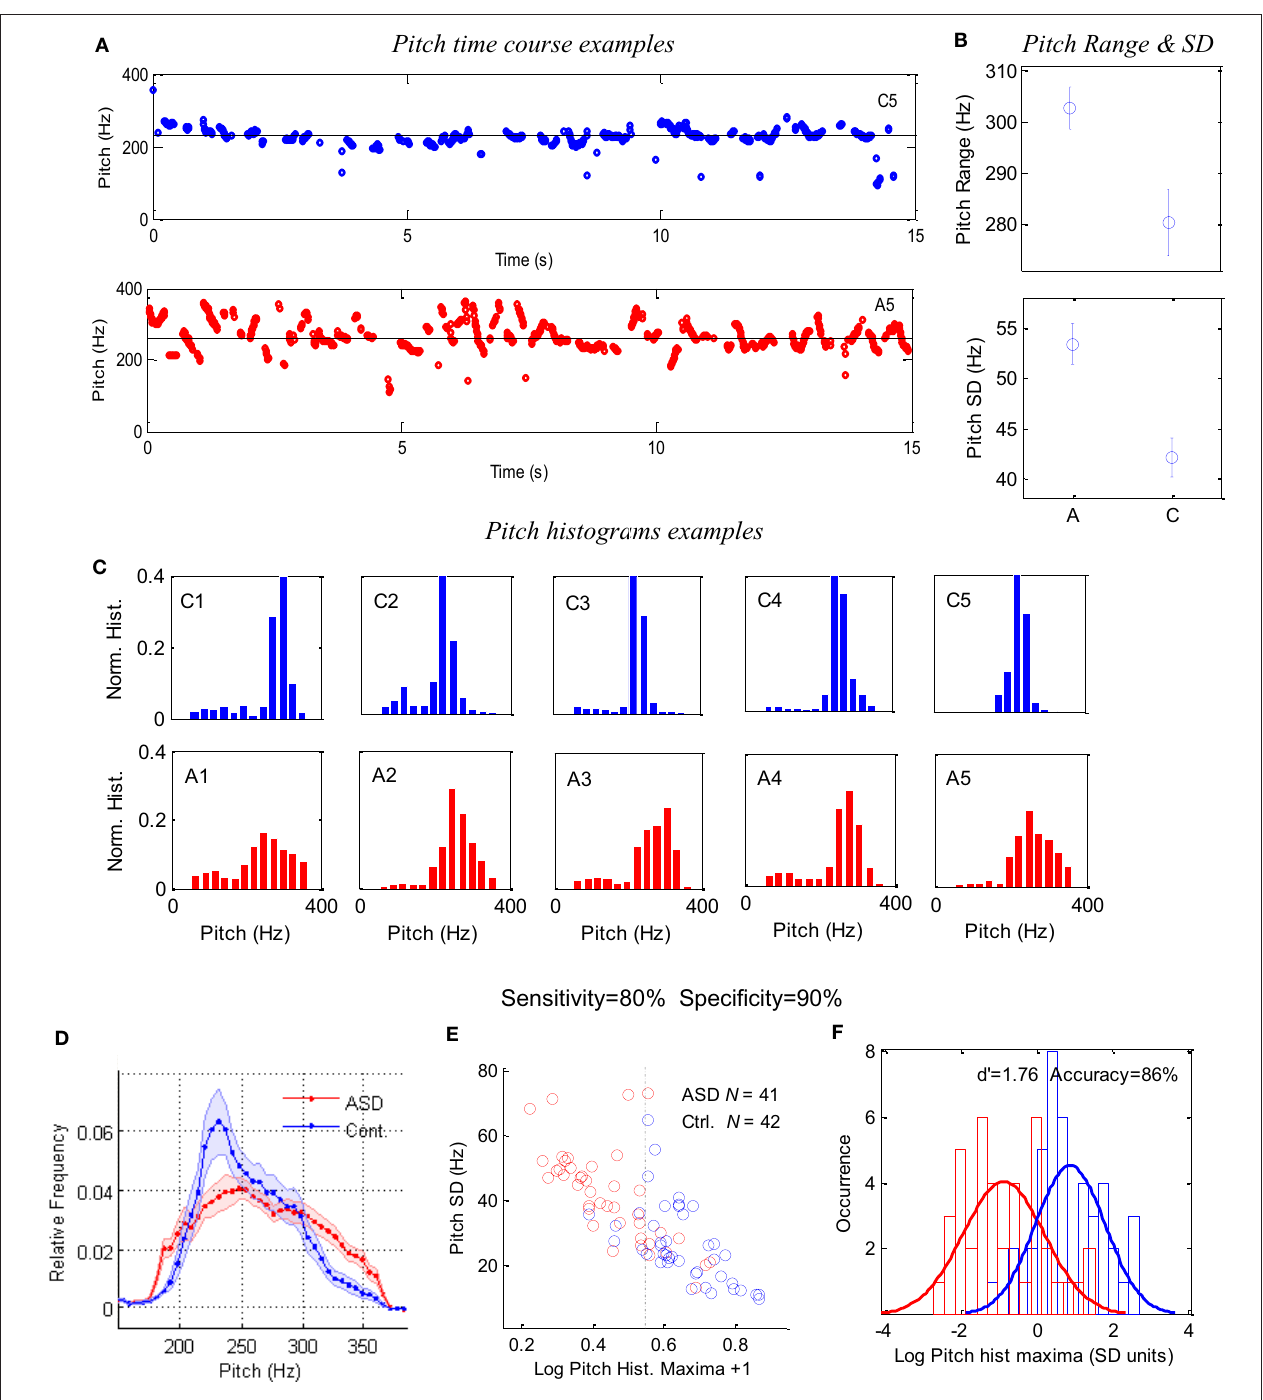
around 220 Hz showing a highly significant difference ( p < 0.002). (e) A scatter plot for the pitch histogram height (log units, x -axis) and pitch SD ( y -axis), with each point corresponding to one child. (F) Occurrence histogram for the data in (e) along the x -axis (pitch histogram maxima) with a Gaussian fit for each group, presented in SD units (average across groups) around the average of the means. The difference between the groups corresponds to a d ′ of 1.76 and a threshold criterion allows 86% success in classification, with a sensitivity of 80%, a specificity of 90%, and a positive predictive value of 89% (four controls classified as ASD and eight ASD as